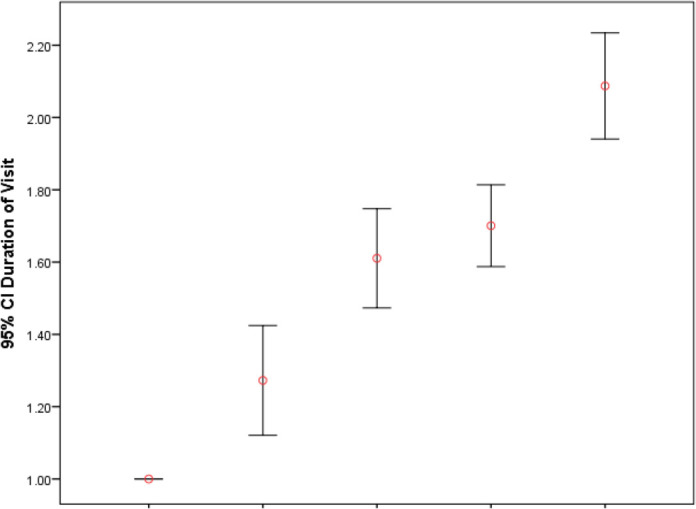
Relation between duration of visit and satisfactory communication with the Doctor.